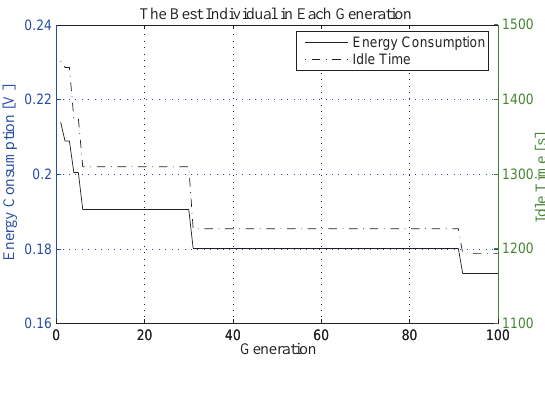
Fig. 10. Result of simulation